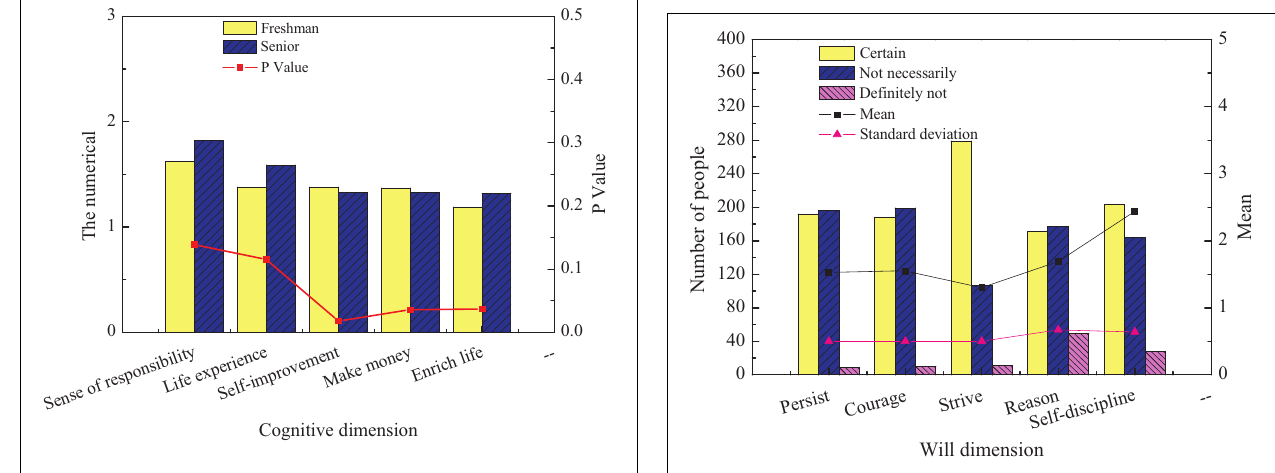
FIGURE 10 | Comparison of freshmen and senior students’ entrepreneurial emotion. FIGURE 11 | Comparison of students’ entrepreneurial